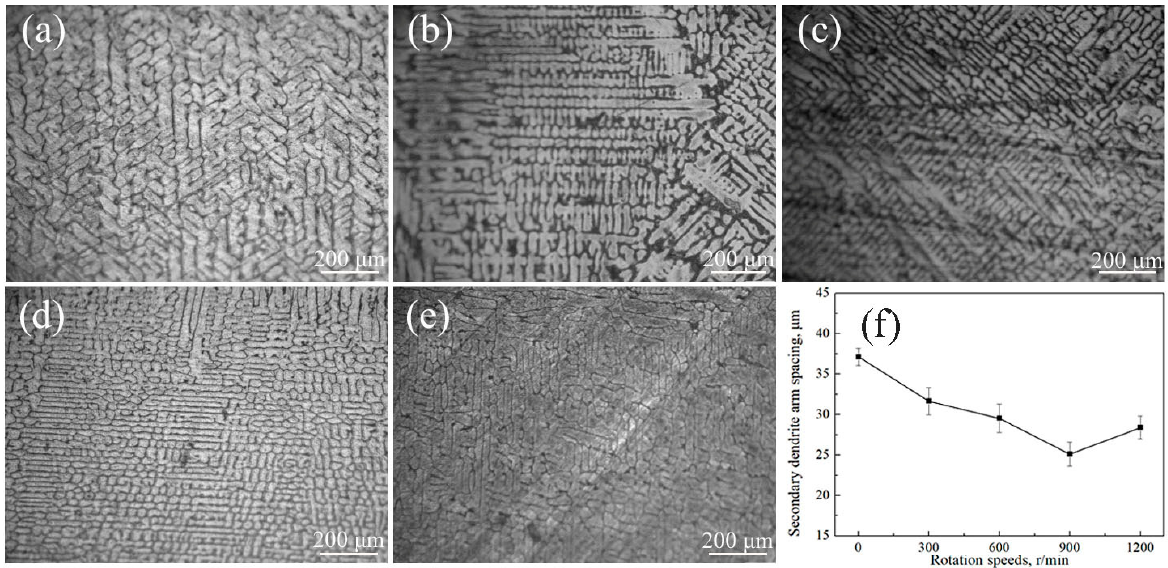
Figure 3. Microstructures of the Ag–1.5Cu–1.0Y alloys at different rotation speeds of 0 r/min ( a ), 300 r/min ( b ), 600 r/min ( c ), 900 r/min ( d ), and 1200 r/min ( e ). Secondary dendrite arm spacing ( λ 2 ) of the Ag–1.5Cu–1.0Y alloys with different rotation speeds ( f ).